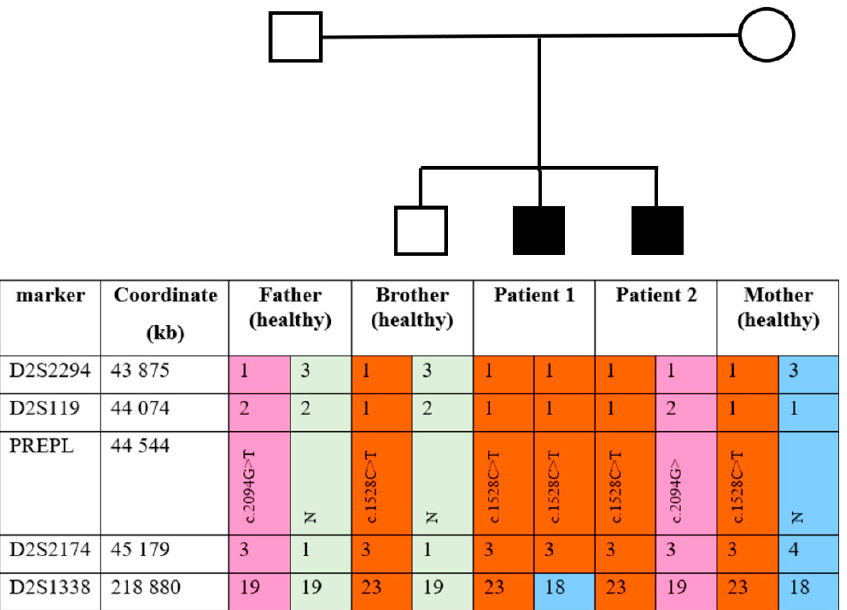
Figure 2. The family’s haplotypes at chromosome 2 markers.